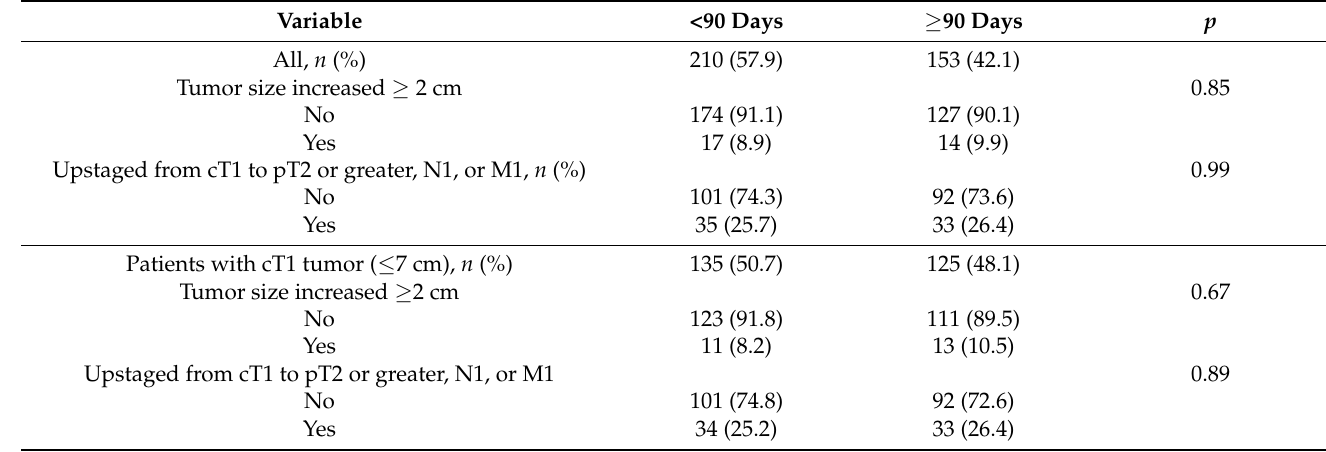
Table 2. Impact of surgical wait time on tumor characteristics.